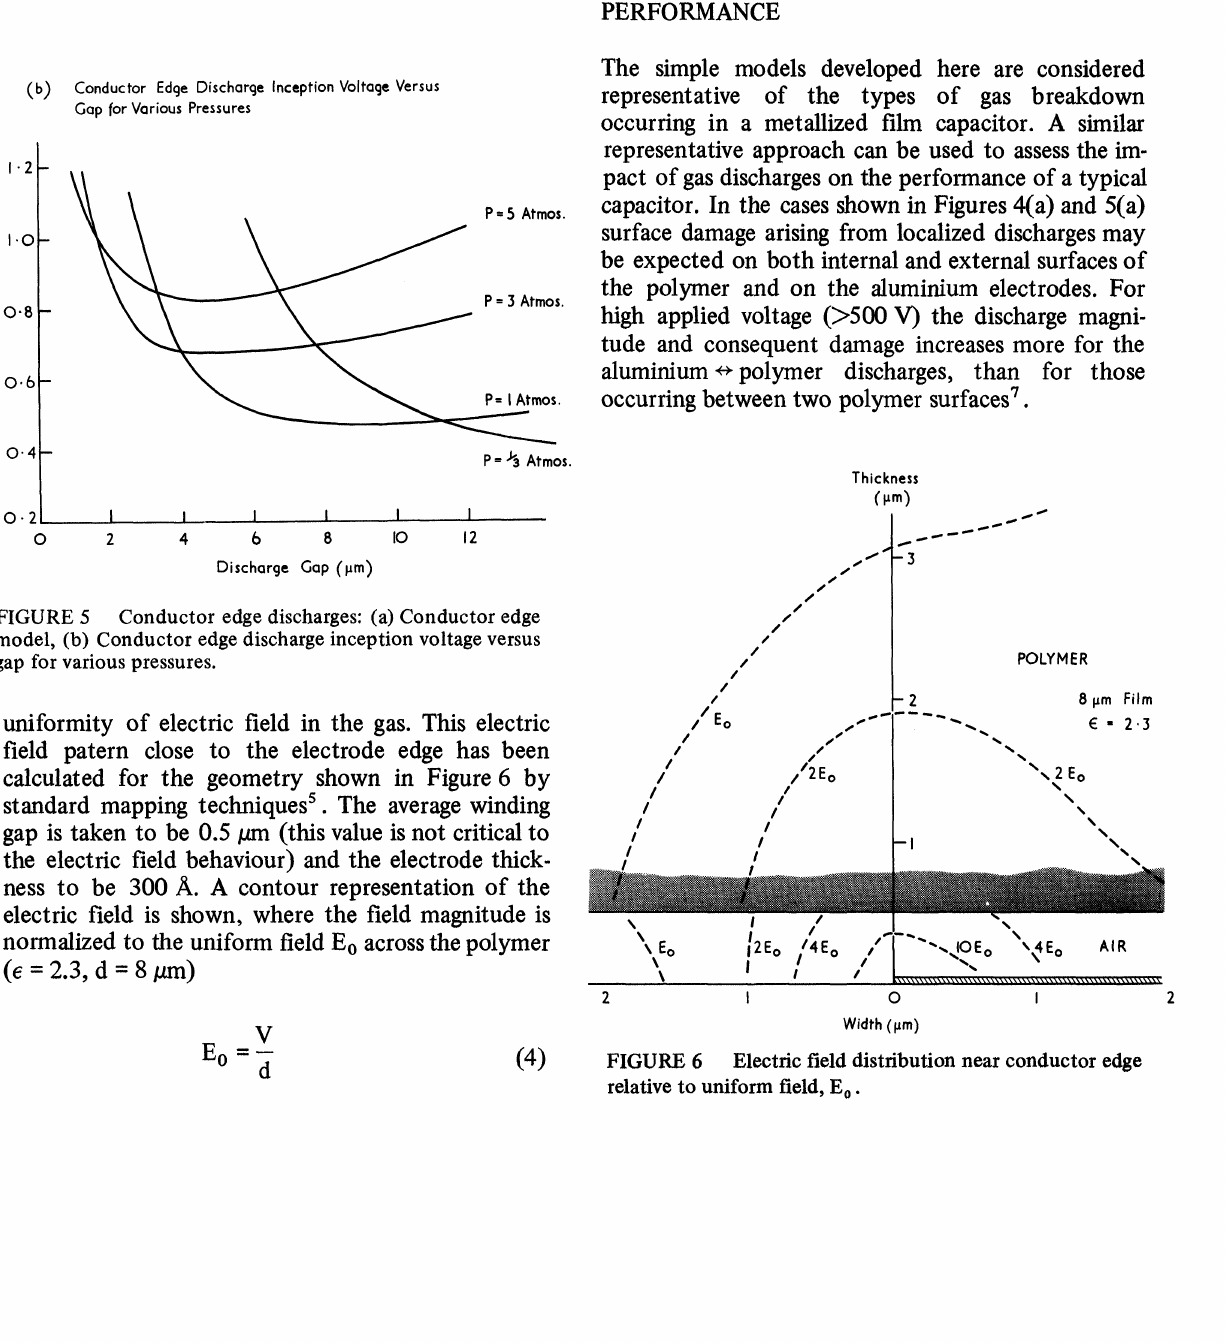
Electric field distribution near conductor edge relative to uniform field,